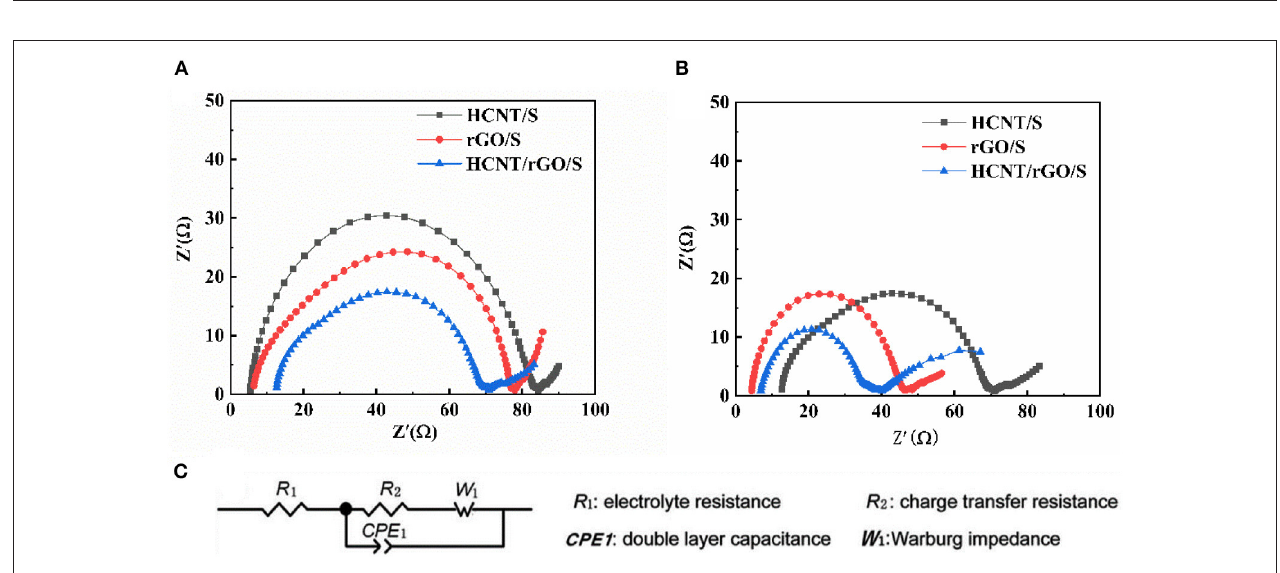
FIGURE 10 | Electrochemical impedance spectrum (EIS) of the cells with different cathodes (A) before cycling and (B) after cycling at